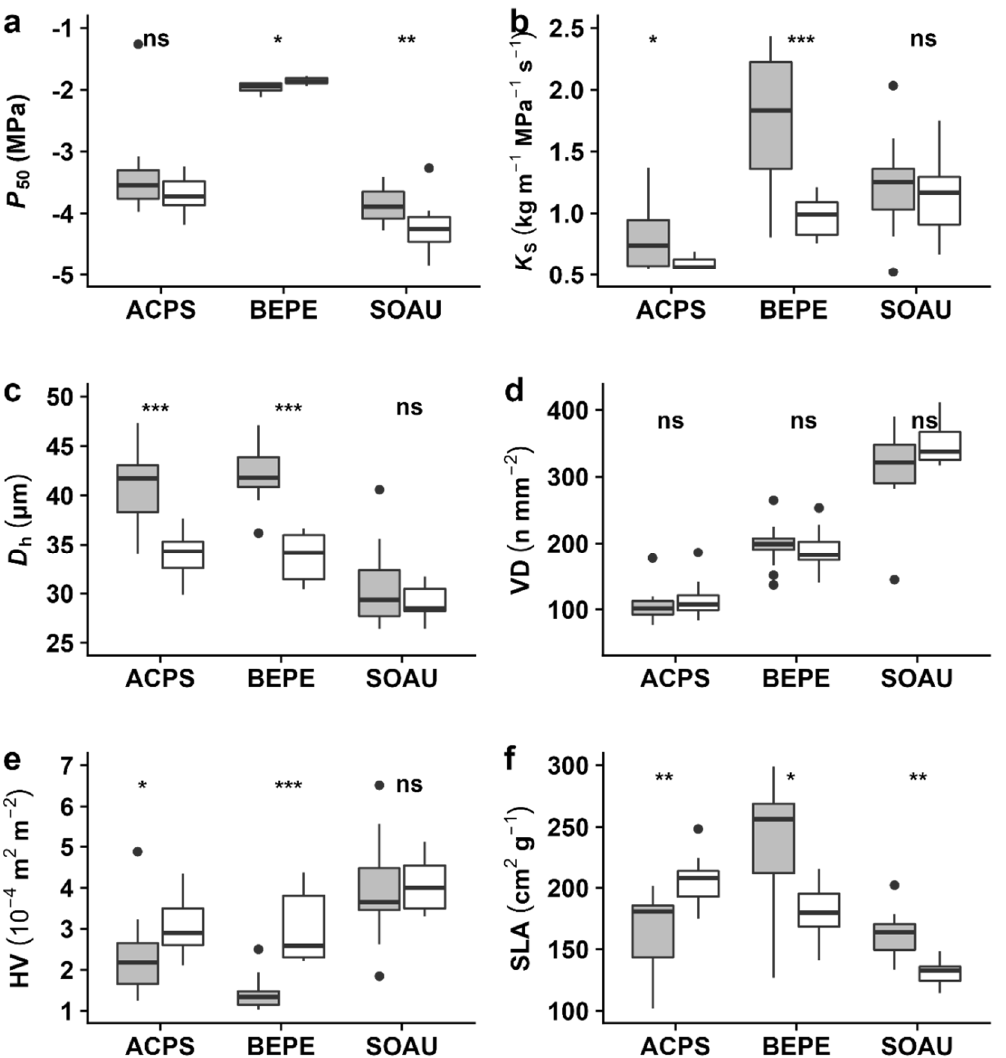
Figure 3. Boxplot depicting the variability between treatments for hydraulic, wood anatomical, and leaf morphological traits for the three species. Given are ( a ) water potential at 50% loss of hydraulic conductivity ( P 50 ), ( b ) specific conductivity ( K S ), ( c ) hydraulically-weighted vessel diameter ( D h ), ( d ) vessel density (VD), ( e ) Huber value (HV), and ( f ) specific leaf area (SLA) for the control (grey) and stress (white) treatment. Asterisks indicate the level of significance (*, p < 0.05; **, p < 0.01; ***, p < 0.001; ns, for non-significant). For species abbreviations, see Figure 1. We found significant differences between treatments with regards to leaf